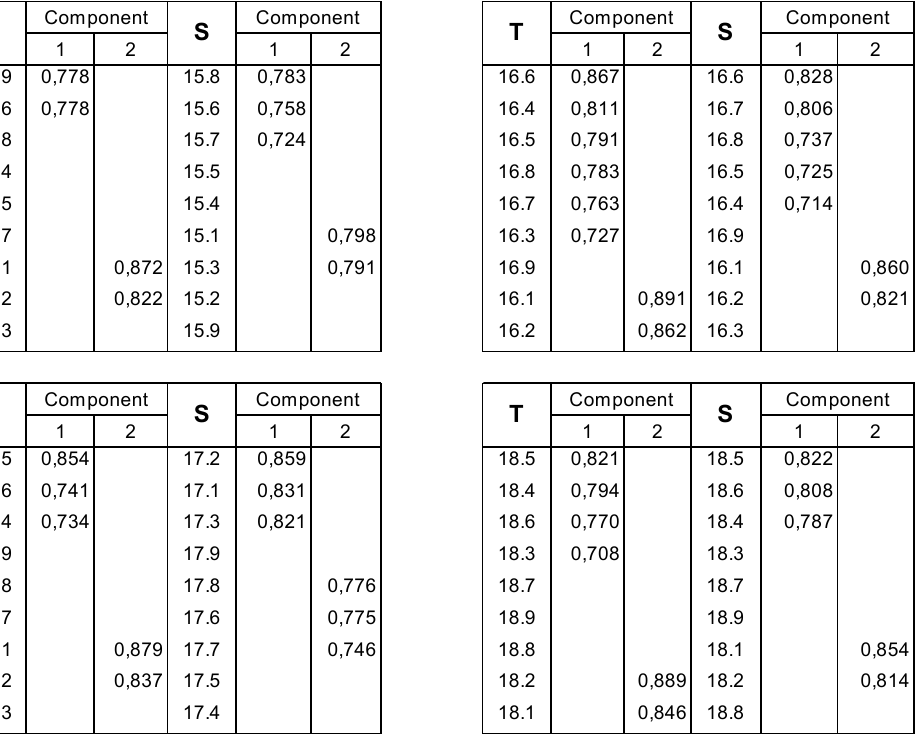
Figure 8. Rotated Component Matrix regarding the science area. Extraction Method: Principal Component Analysis. Rotation converged in three iterations.